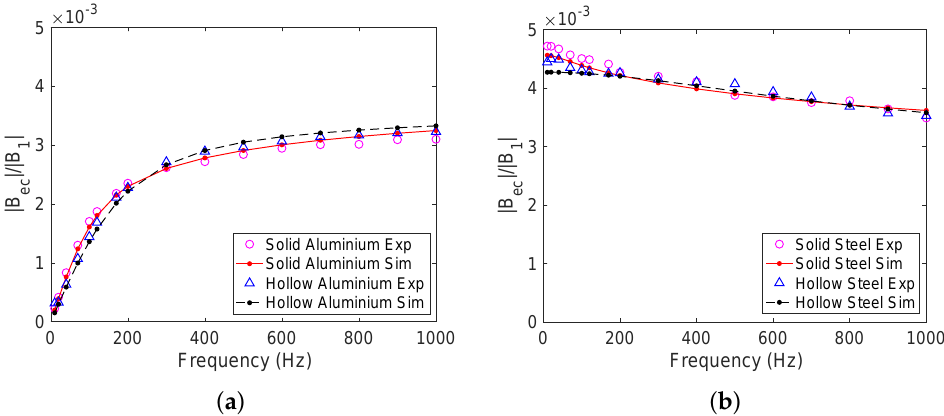
Figure 7. Experimental and simulated results for secondary magnetic fields from solid and hollow cylinders at frequencies between 10 Hz and 1 kHz for ( a ) 6061 T6 aluminium and ( b ) 440c